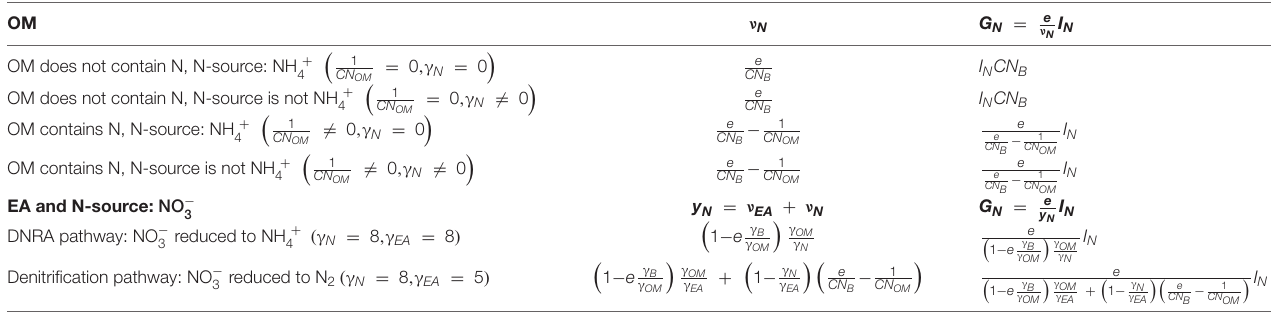
TABLE 2 | Values of the stoichiometric coefficients for the N-source ( ν N ) and microbial growth rate ( G N ), for various types of OM and N Inorg -sources. OM ν N G N = e ν OM does not contain N, N-source: NH + 4